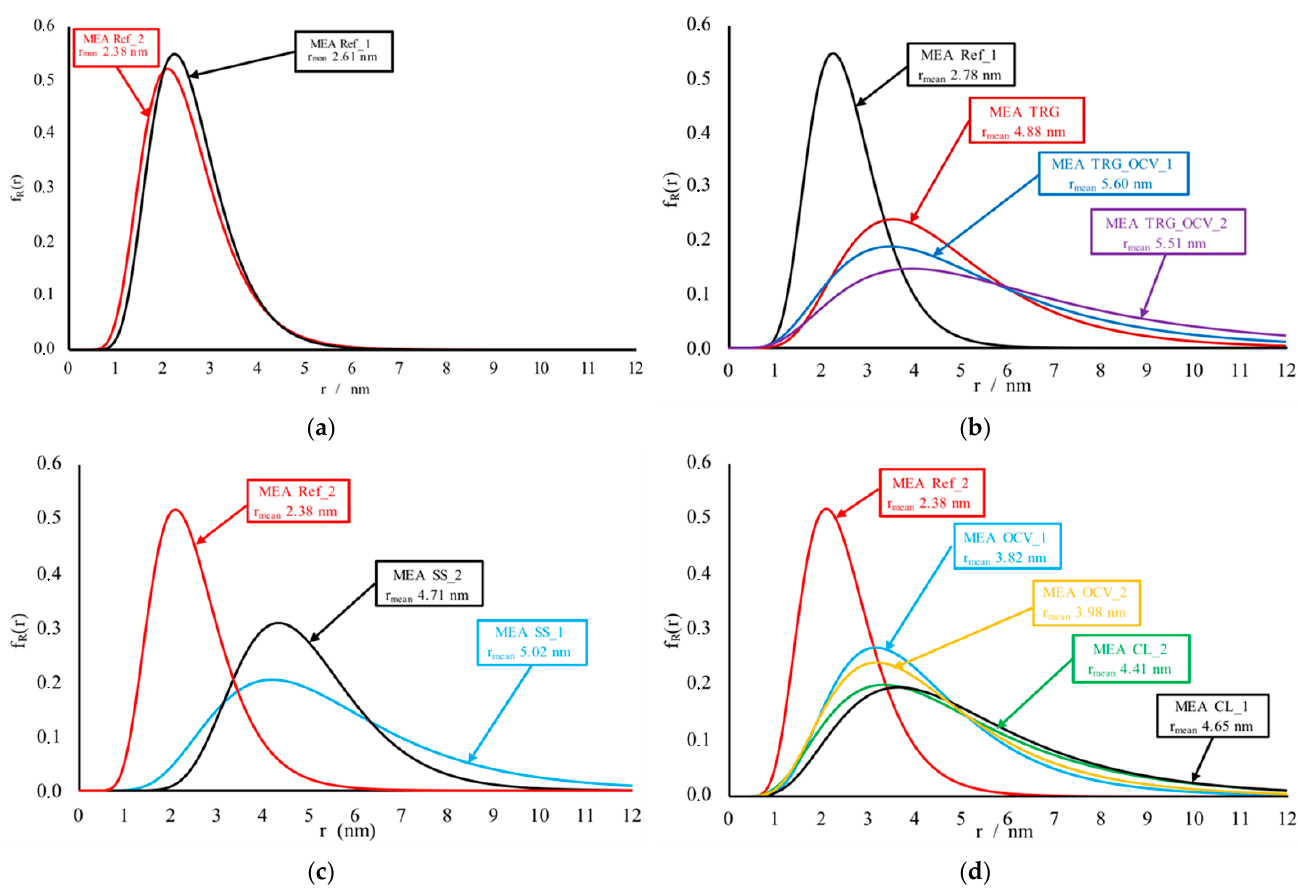
Figure 5. Pt nanoparticles size distribution. ( a ) MEA Ref_1 (black line) and Ref_2 (red line), ( b ) MEA Ref_1 (black line), TRG (red line), TRG_OCV_1 (grey line) and TRG_OCV_2 (purple line), ( c ) MEA Ref_2 (red line), SS_2 (black line), SS_1 (blue line), ( d ) MEA Ref_2 (red line), OCV_1 (blue line) and OCV_2 (yellow line), CL_2 (green line) and CL_1 (black line).